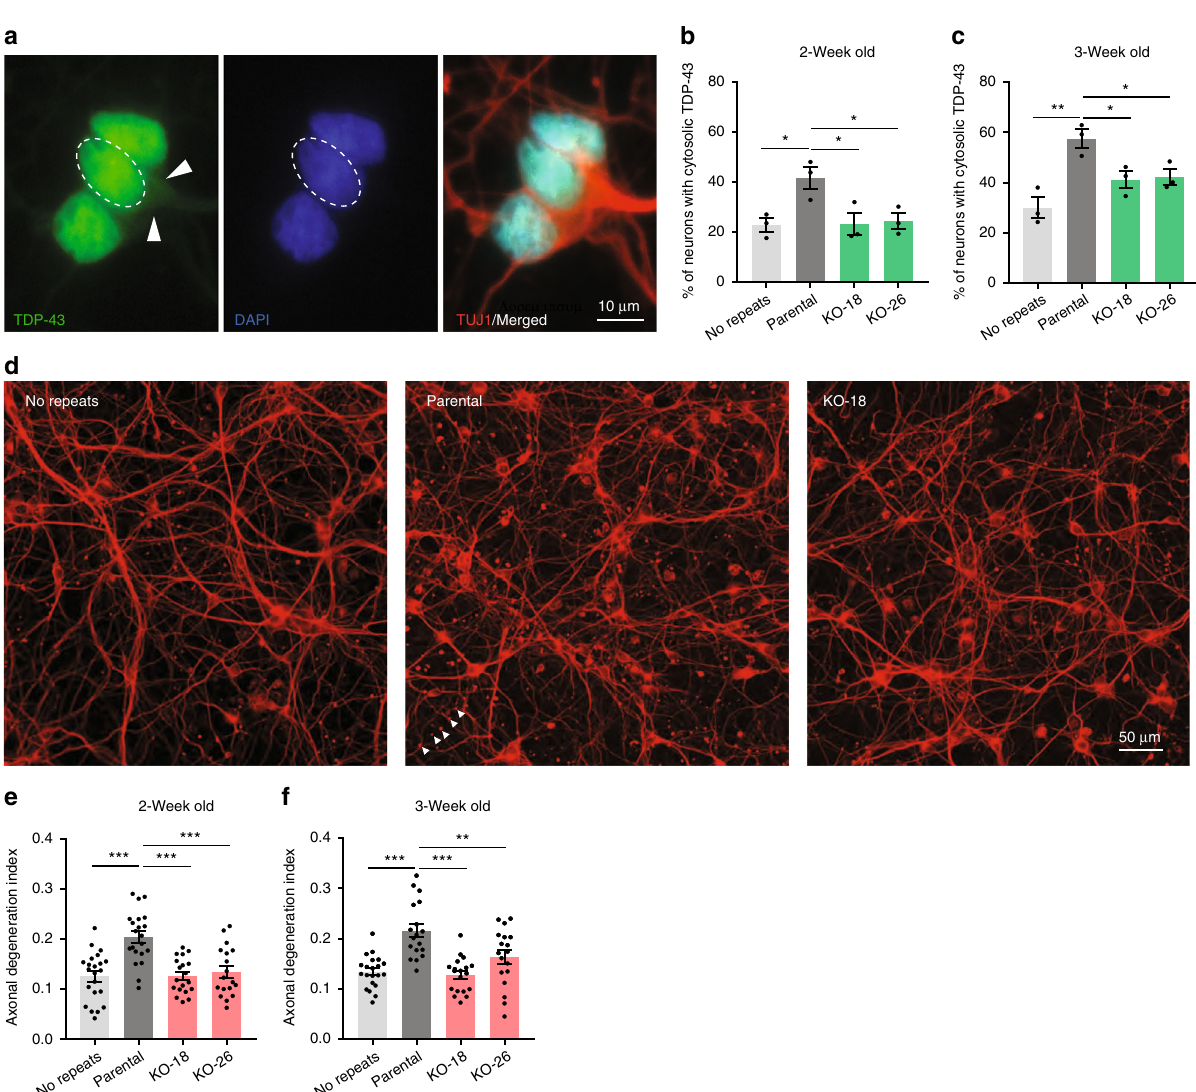
Fig. 9 AFF2 knockout rescues disease phenotypes. a Representative immuno fl uorescence image of the TDP-43 localization in cortical neurons. Arrowheads indicate TDP-43 in the cytoplasm. Quanti fi cation of the percentage of C9ORF72 iPSC-derived neurons showing cytoplasmic TDP-43 after neurotrophic factor withdrawal for 2 weeks ( b ) or 3 weeks ( c ). d Axonal degeneration was examined with the use of the marker βΙΙΙ -tubulin (TUJ1), which allows the visualization of swollen varicosities and axonal fragments. Panels show representative immuno fl uorescence images for no repeats, parental and AFF2 -KO- 18 neuronal cultures. Arrowheads show an example of a fragmented axon. Quanti fi cation of axonal degeneration by measuring the ratio of fragmented axons over the total TUJ1 + area 2 weeks ( e ) or 3 weeks ( f ) after neurotrophic factor withdrawal. Six to eight randomly selected fi elds were analyzed for each condition and each neuronal culture. Each independent data point represents one fi eld. n = 3 independent differentiations. Values are mean ± s.e.m. * p < 0.05; ** p < 0.01; *** p < 0.001 (one-way ANOVA, Dunnett's multiple comparisons test). Source data are provided as a Source Data fi 1× Glutamax, 0.1 μ M compound E (Calbiochem), and 1 μ g/ml laminin (Sigma)) for experiments were done with neurons derived from 3 – 5 independent differentia- 2 – 3 weeks. This protocol generated a culture with >90% TUJ1 + neurons. The work tions. Human brain cDNA samples were from a previous study 40 . The mean age at death was 78 ±8 years in seven control subjects and 65 ±7 years in six C9ORF72 involving iPSCs was approved by the Institutional Biosafety Committee of the repeat expansion carriers. University of Massachusetts Medical School, Worcester. A shorter cortical differentiation protocol was used for the TDP-43 and axonal degeneration assays. Brie fl y, iPSC colonies were seeded on Matrigel-coated wells in mTeSR1 medium (StemCell Technologies); 24 h later, the medium was changed to neuroepithelial progenitor (NEP) medium (1:1 DMEM/F12:neurobasal, 0.5× N2, TRCN0000108068 for AFF3 ). High-titer lentiviral preparations were produced by 0.5× B27, 0.1mM ascorbic acid (Sigma), 1× Glutamax, 3 μ M CHIR99021 (Tocris the Viral Vector Core at the University of Massachusetts Medical School. Bioscience), 2 μ M DMH1 (Tocris Bioscience), and 2 μ M SB431542 (Stemgent)) and replaced every other day for 6 days. Progenitor colonies were dissociated with Accutase, seeded at 1:6 on Matrigel-coated wells, and cultured in NEP medium Generation of AFF2 -KO iPSC lines . Genome editing with the CRISPR-Cas9 containing 2 μ M cyclopamine (StemCell Technologies) for 6 days; the medium was system to create a deletion to knock out AFF2 was done by ALSTEM (Richmond, replaced every other day. Cortical progenitors were lifted, cultured in suspension CA). Brie fl y, the Neon electroporation system was used to transfect iPSCs with two for 6 additional days in the absence of CHIR99021, DMH1, and SB431542, and different guide RNAs: ATCTCTTTGTAGGATGCTTG and TCTAACCTGGTAG dissociated to single cells with Accutase. Cells were seeded on poly-lysine/laminin- AGCTCAG for patient 1 iPSCs and ATCTCTTTGTAGGATGCTTG and AGCC coated coverslips (Corning) in neurotrophic factor withdrawal medium (1:1 CTAAGCTCTTCTAACC for patient 2 iPSCs. Single cells were placed in 96-well DMEM/F12:neurobasal, 0.5× N2, 0.5× B27, 0.1 mM ascorbic acid (Sigma), plates, cultured for 14 days, expanded, and cultured in 24-well plates. Genomic